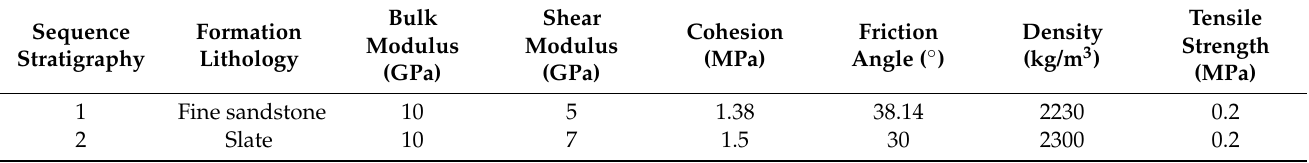
Table 3. Stratigraphic lithological